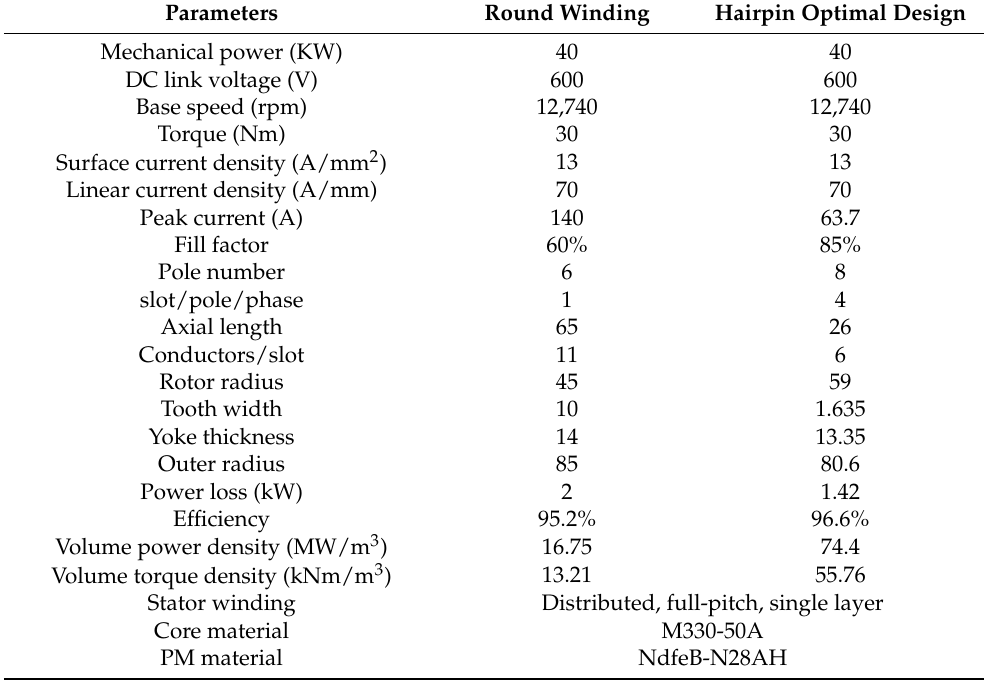
Table 1. Comparison between the motor with random windings and the motor with hairpin windings [12]. Parameters Round Winding Hairpin Optimal